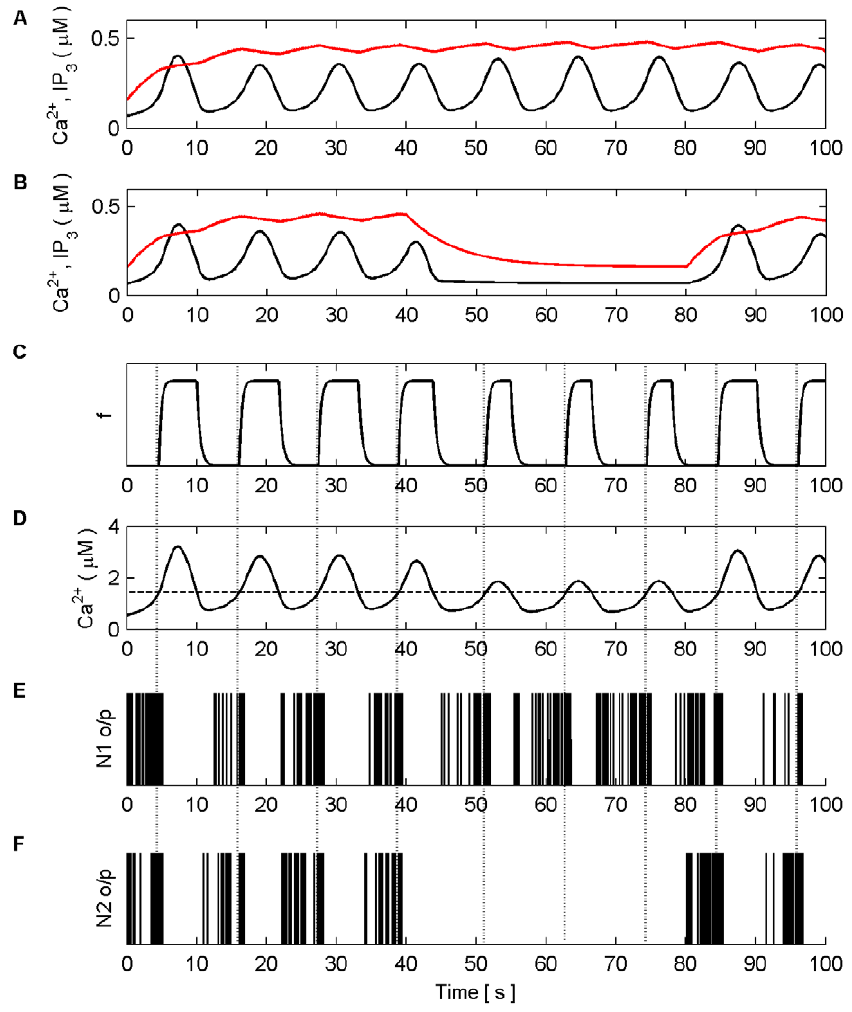
Figure 10. Ca 2 + oscillations and resulting coordination. (A) Ca 2 + oscillations (black line) and IP 3 levels (red line) at a synapse from N1 stimulated by 7 Hz Poisson spike train for 100 s. (B) Ca 2 + oscillations at a synapse from N2 which is only stimulated from 0–40 s and 80–100 s with a 7 Hz Poisson spike train. (C) Activity of the gating function f which is activated when the total level of Ca 2 + (D) within the astrocyte passes the threshold (D-black dashed line). (E and F) The output firing activity of neurons N1 and N2. Note that when the total Ca 2 + oscillation crosses the threshold from below both neurons fire with a significantly higher frequency of activity; a result of the global release of glutamate and NMDA SIC activation. These are the only times that the neurons are highly coordinated. Furthermore it can be seen that there are extended periods of silence from both neurons after firing in bursts. This is a result of the negative feedback from f which depresses the release of neurotransmitter from the synapses and remains active until the Ca 2 + oscillation crosses the threshold from